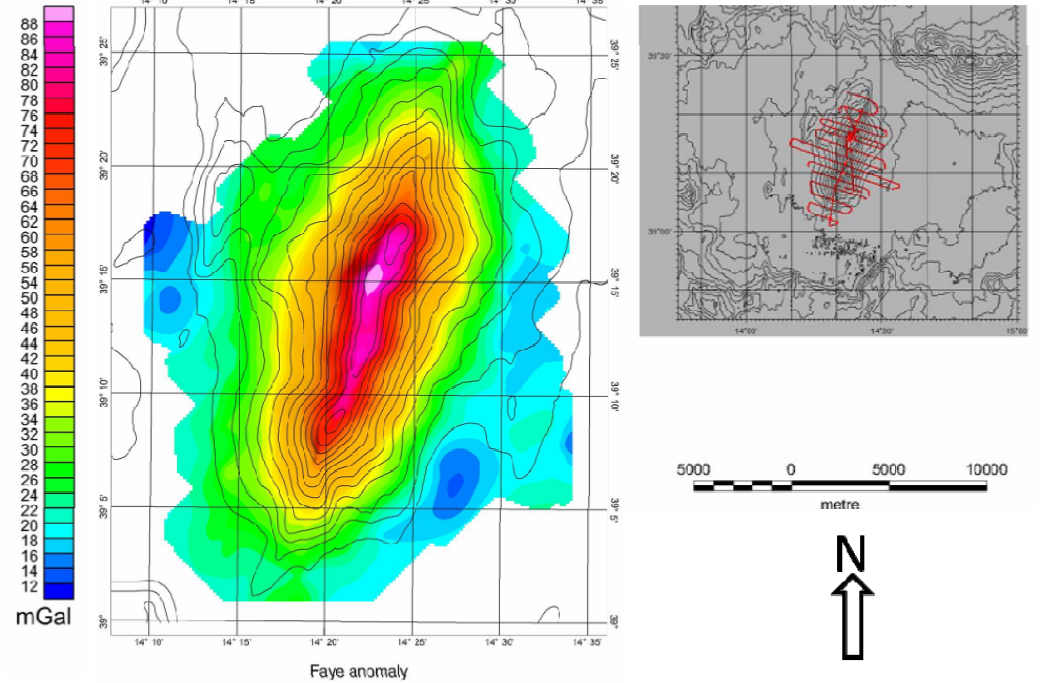
Figure 5. Faye anomaly field of Marsili seamount; values of the gravity field in mGal (modified after